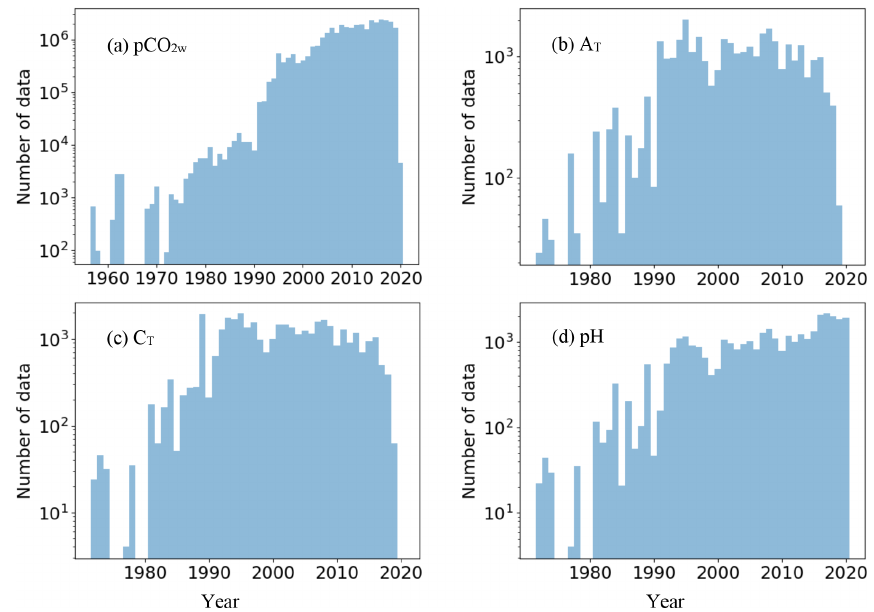
Figure 1. Numbers of carbonate system measurements included in the database per year. (a) Seawater pCO 2 , (b) total alkalinity ( A T ), (c) dissolved inorganic carbon (C T ) and (d)